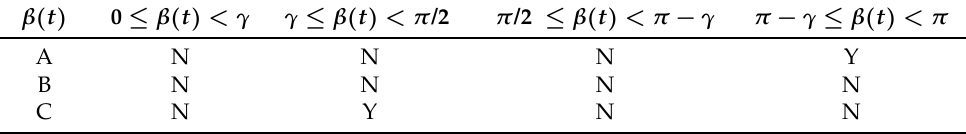
Table 1. Occlusion of scattering centers under different semi-cone angles γ and the angle of view β